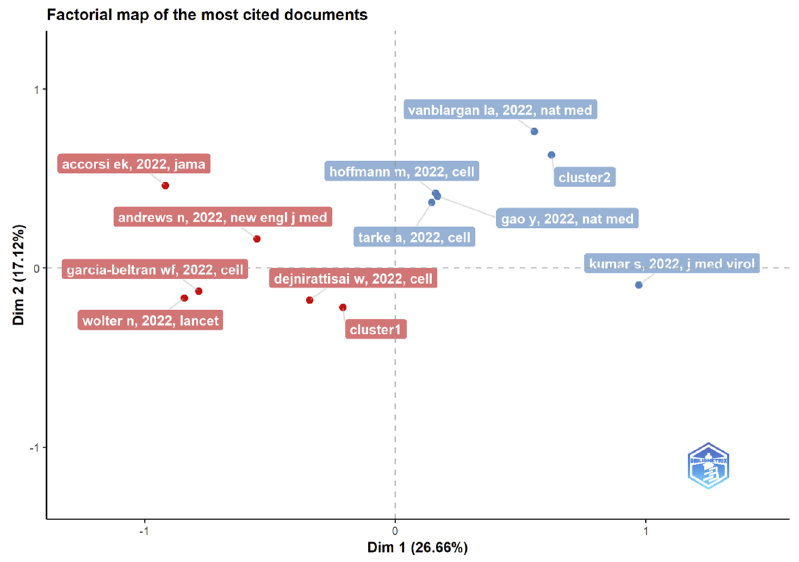
Figure 18. Factorial map using a correspondence analysis of the most cited documents related to Omicron ‐ based research.).